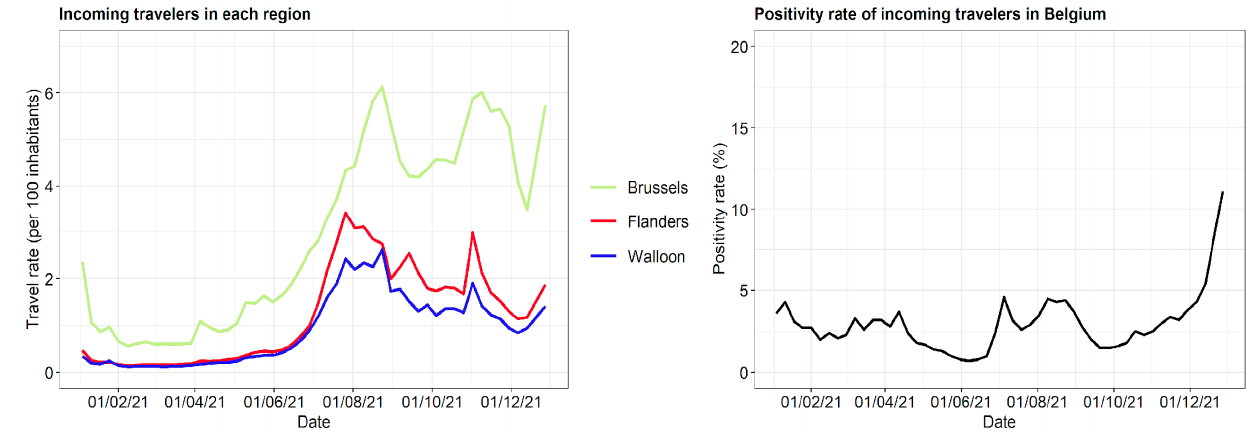
Figure 6. Weekly incoming travelers and COVID-19 positivity rates of incoming travelers in Bel- gium.